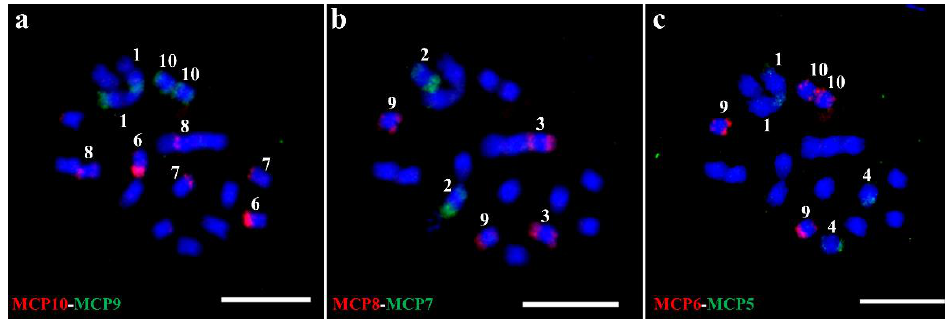
Figure 2. Sequential FISH identifying each of the ten chromosomes in sorghum. ( a ) First round of FISH using MCP10 (digoxigenin-red) and MCP9 (biotin-green) probes. ( b ) Second round of FISH using MCP8 (digoxigenin-red) and MCP7 (biotin-green) probes. ( c ) Third round of FISH using MCP6 (digoxigenin-red) and MCP5 (biotin-green) probes. Arabic numerals denote the chromosome number in sorghum. Bar = 10 μm.